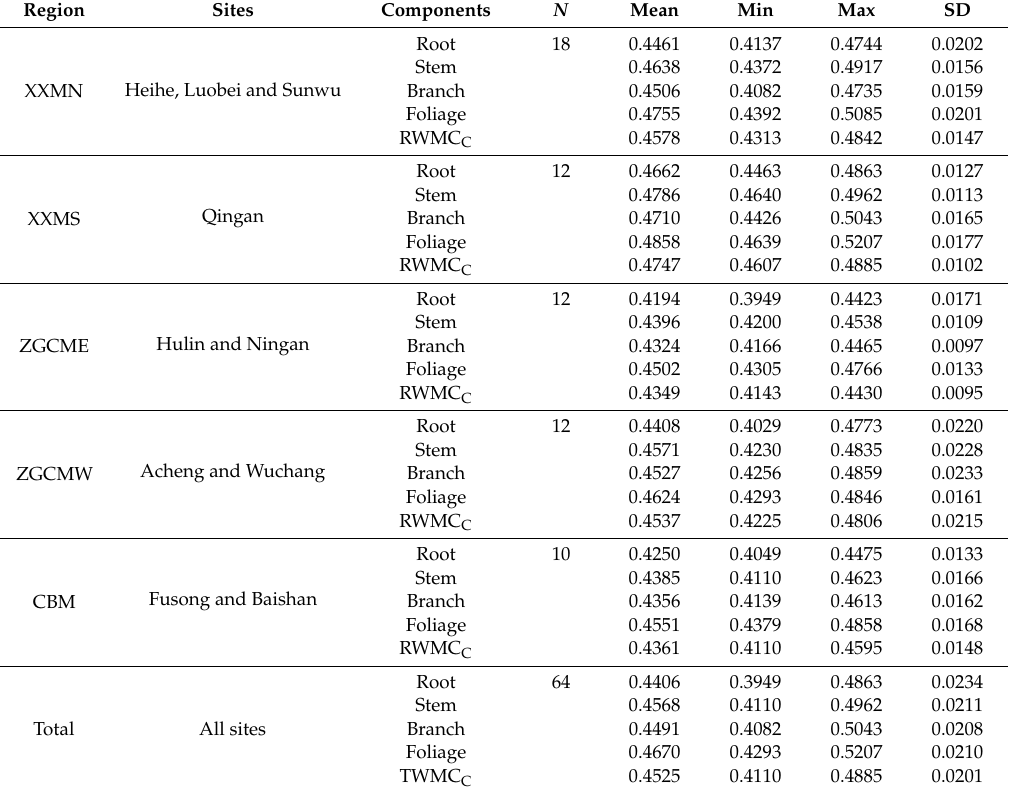
Table 2. Carbon concentration statistics for Mongolian oak by region, component, and weighted mean carbon concentration (WMCC).